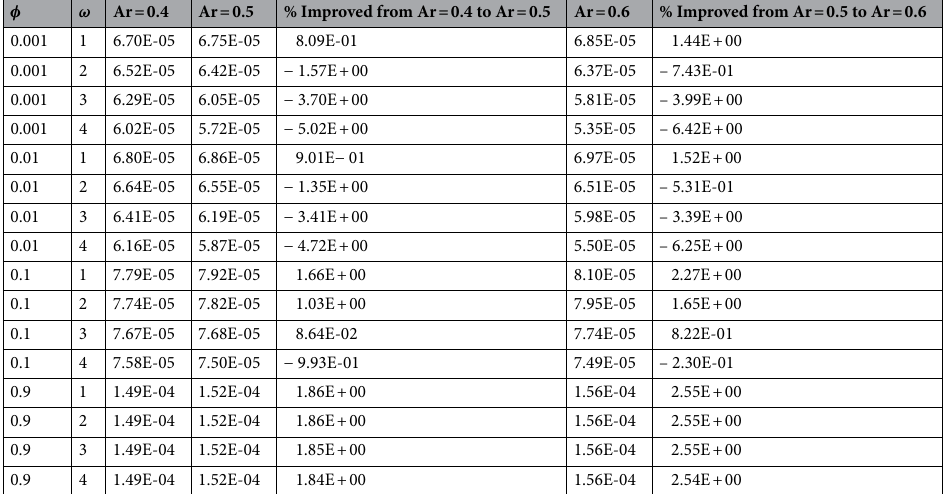
Table 5. All the values of the average skin friction coefficient in the middle of the